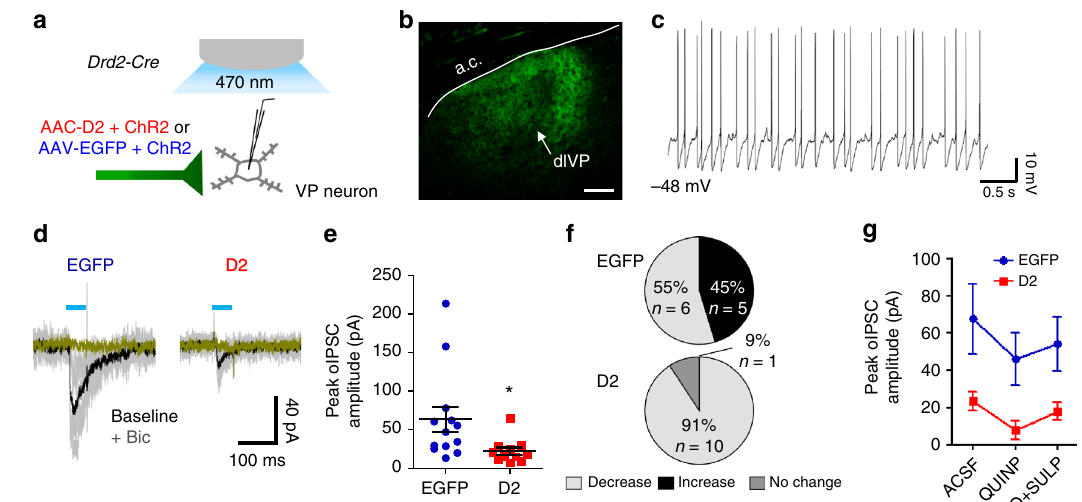
Fig. 4 D2R upregulation reduces D2-MSN inhibitory transmission to ventral pallidum (VP). a Schematic of oIPSCs recordings from VP neurons in slice following blue-light stimulation of terminal fi elds from NAc MSNs co-expressing ChR2 and D2R or ChR2 and EGFP. b VP neurons were recorded from within virus-positive NAc D2-MSN terminal fi elds in the dorsolateral VP (dlVP). Scale bar = 150 µ m. c Target neurons in VP typically displayed spontaneous fi ring activity, depolarized RMP, slow ramp-like depolarization preceding short duration spikes, and prominent afterhyperpolarization. d Individual (gray) and average (black) oIPSC traces (gray) from representative MSNs following fi ve 50-ms light pulses (1 Hz). Bicuculline (10 µ M) eliminated the oIPSC. e Peak oIPSC amplitude under basal conditions was signi fi cantly reduced when D2Rs were overexpressed in D2-MSNs MSNs [ n = 13 cells (10 mice) or 11 cells (7 mice)]. f Quinpirole (1 µ M) bidirectionally modulated oIPSCs recorded in EGFP NAcInd VP neurons MSNs [ n = 11 cells (9 mice) or 10 cells (6 mice)]. In contrast, quinpirole decreased the oIPSC amplitude in >90% of cells recorded in D2R-OE NAcInd VP. g Opposite in fl uences of D2 agonist and antagonist are highlighted by the overall effect of quinpirole and quinpirole + sulpiride (1 µ M) on oIPSC amplitude. Error bars =